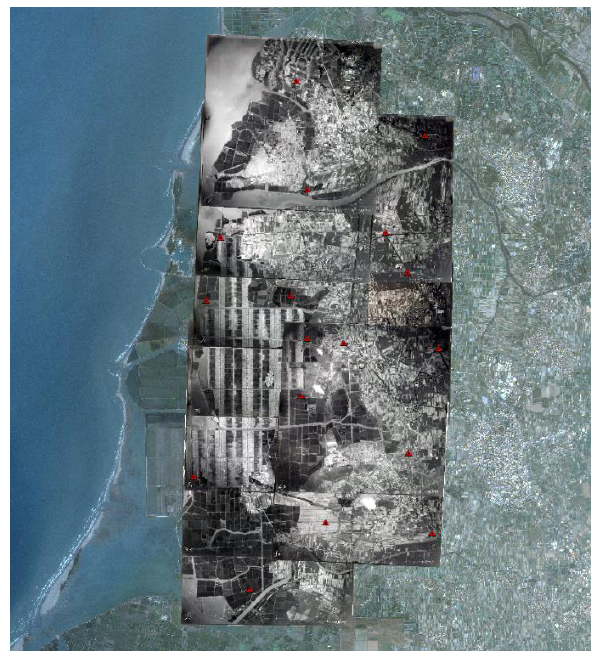
Figure 8. Result of 2D affine transformation.